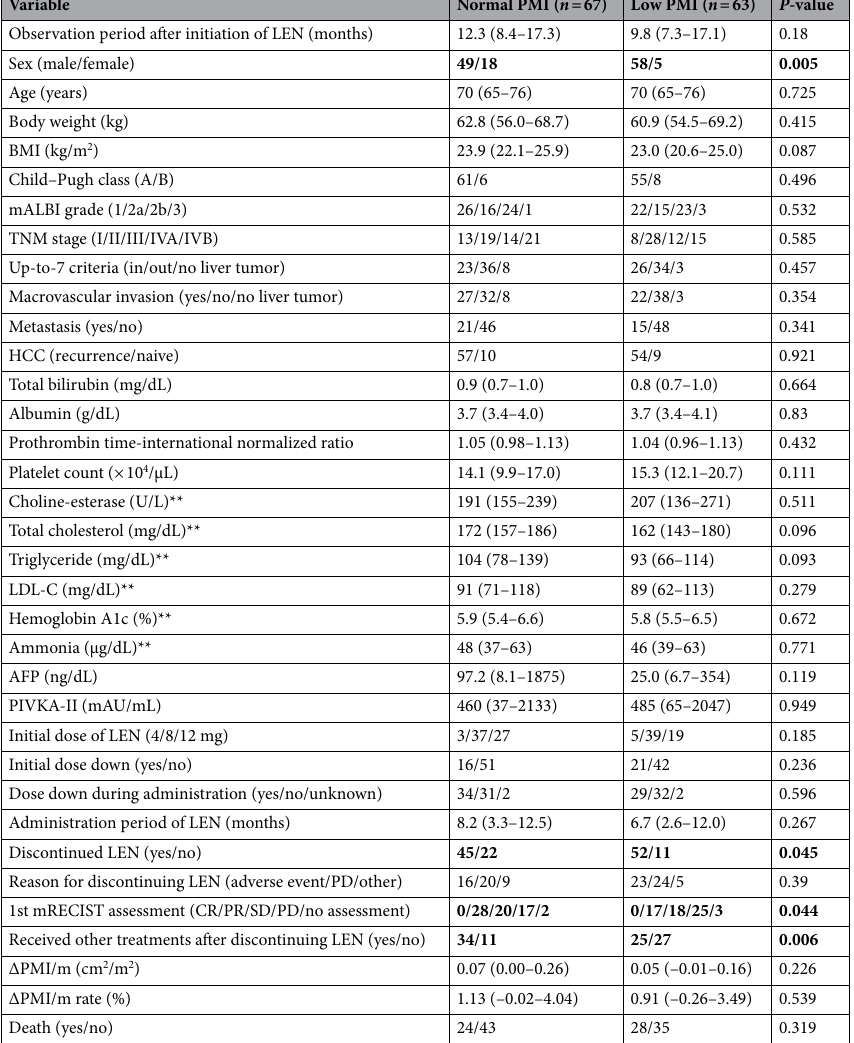
modified albumin-bilirubin, TNM tumor node metastasis, HCC hepatocellular carcinoma, LCL-C low density lipoprotein cholesterol, AFP alpha fetoprotein, PIVKA-II protein induced by Vitamin K absence or antagonists-II, PD progressive disease, mRECIST Modified Response Evaluation Criteria in Solid Tumors, CR complete response, PR partial response, SD stable disease, PMI psoas muscle index, ΔPMI/m change in PMI per month, ΔPMI/m rate rate of change in PMI per month during administration of LEN. Low PMI group: PMI < 6.0 cm 2 /m 2 for men and < 3.4 cm 2 /m 2 for women, normal PMI group: PMI ≥ 6.0 cm 2 /m 2 for men and ≥ 3.4 cm 2 /m 2 for women. **Calculated using the available